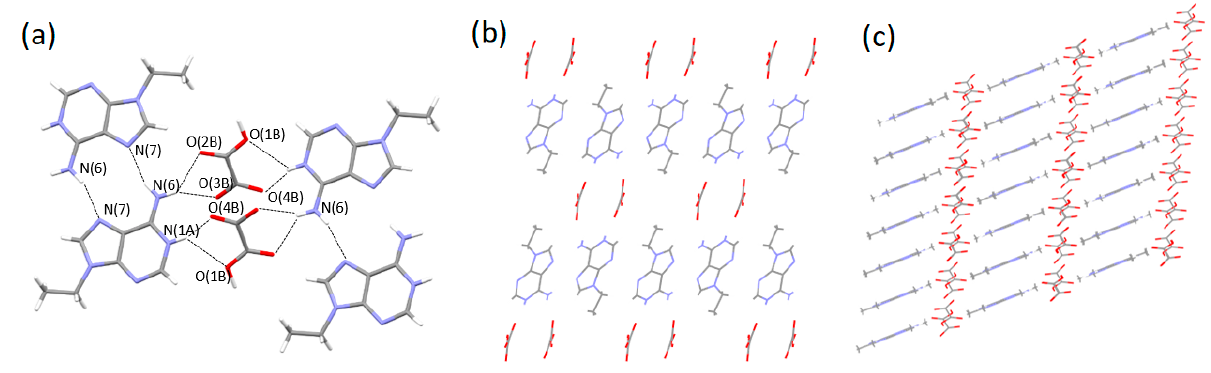
Figure 3. ( a ) Hydrogen bonding interactions, ( b ) layers (view along a axis) and ( c ) view along the vector ( − 2 1 0) in compound 1 (9ETADE-OXA (1:1) salt).